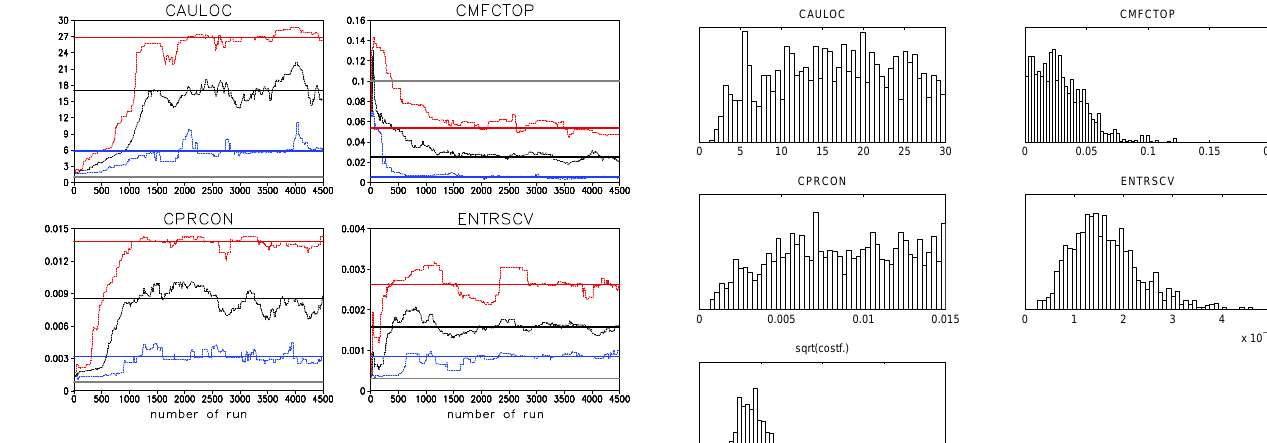
using the last 500 runs only . The blue, black and red dotted lines in Fig. 3 show the 10th, 50th and 90th percentage points computed from these distributions for each of the four param- eters. The solid horizontal lines show the respective percent- age points computed from the last 3500 runs (i.e., runs 1001 through 4500).